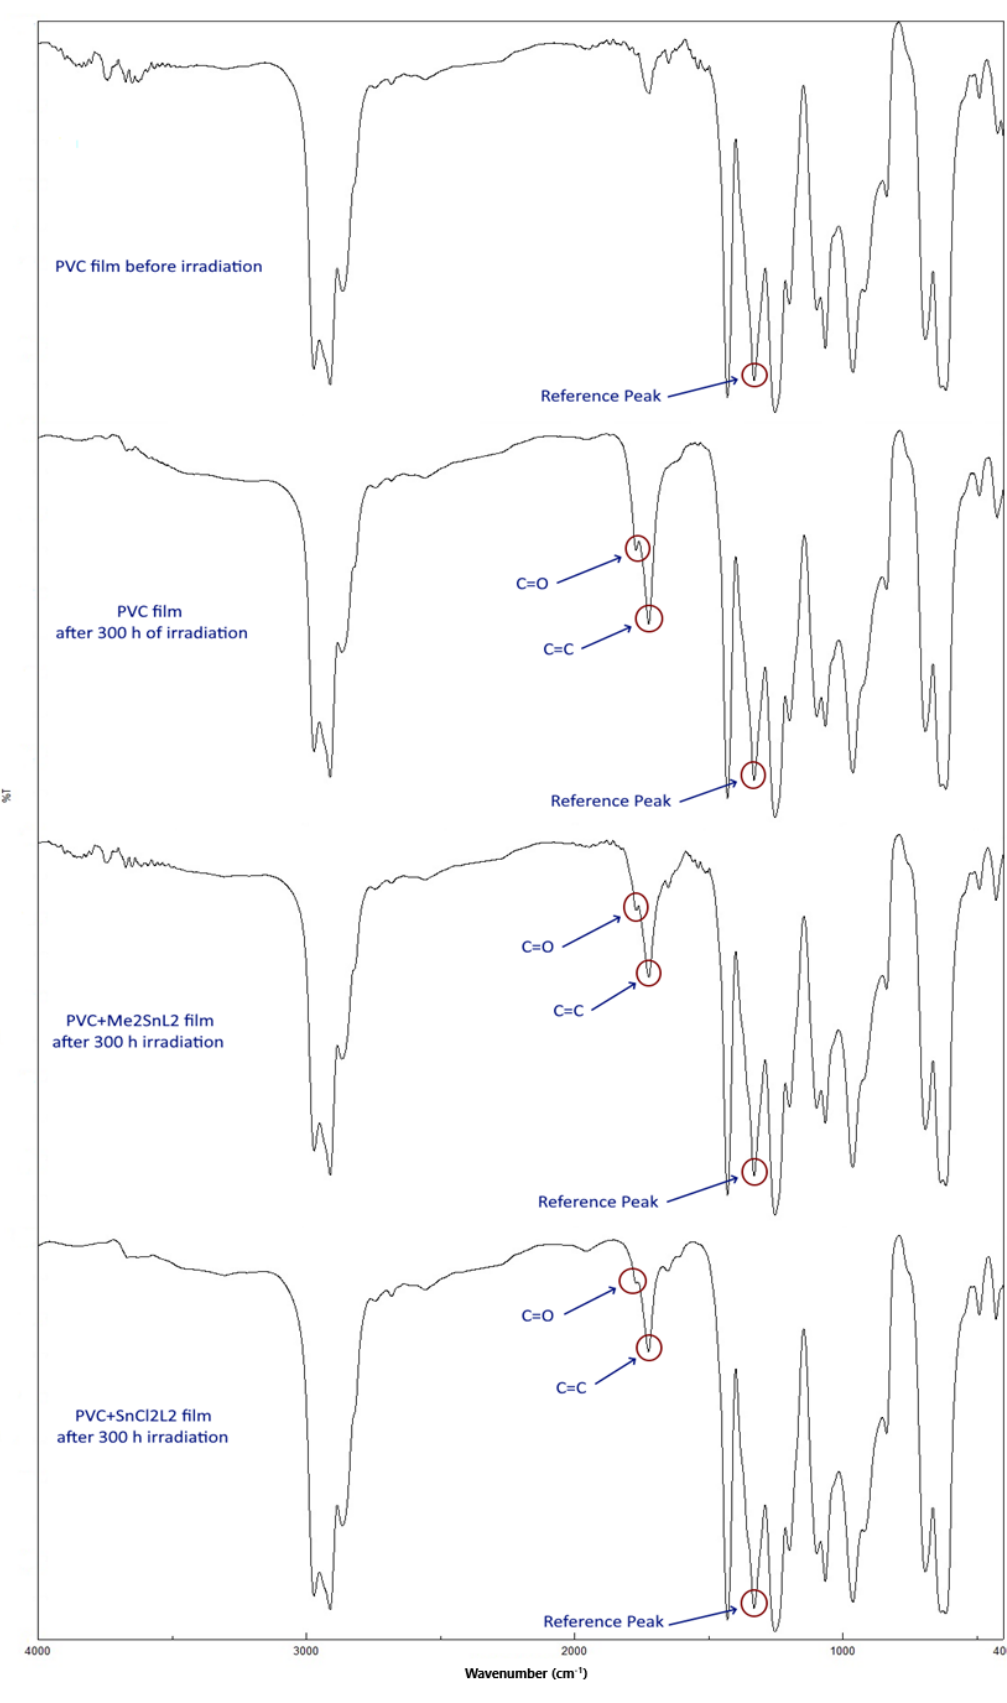
Figure 2. FTIR spectra of PVC films.